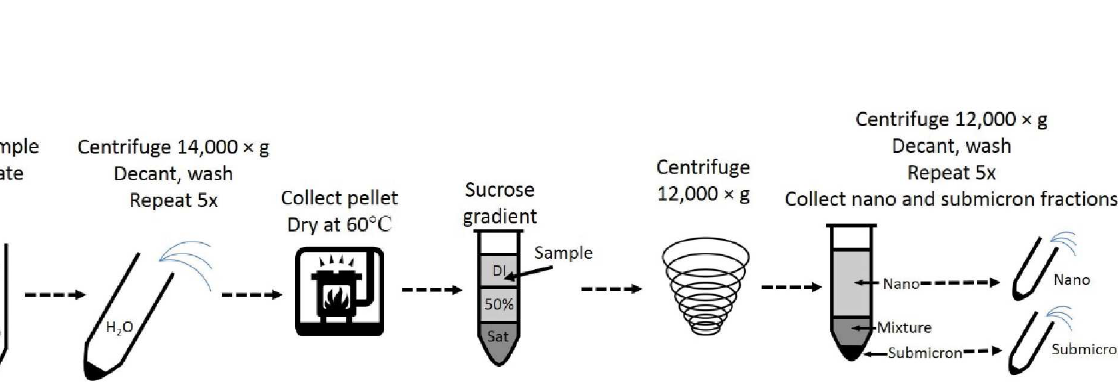
Fig 2. Schematic guide for isolating TiO 2 (E171) from foodstuffs and pharmaceutical products and separating the nano- and submicron-sized fractions.